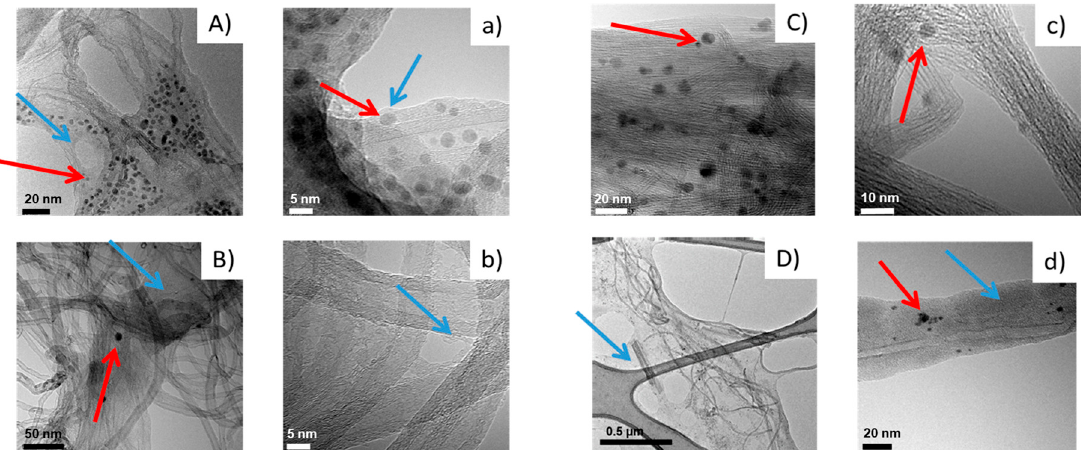
Figure 8. Micrographs of MWCNT/PPGP s ( A , a ), MWCNT/PPGP c (B,b), SWCNT/PPGP s ( C , c ) and SWCNT/PPGP c ( D , d ) adducts isolated from 1 mg/mL water dispersions. Micrographs are: low